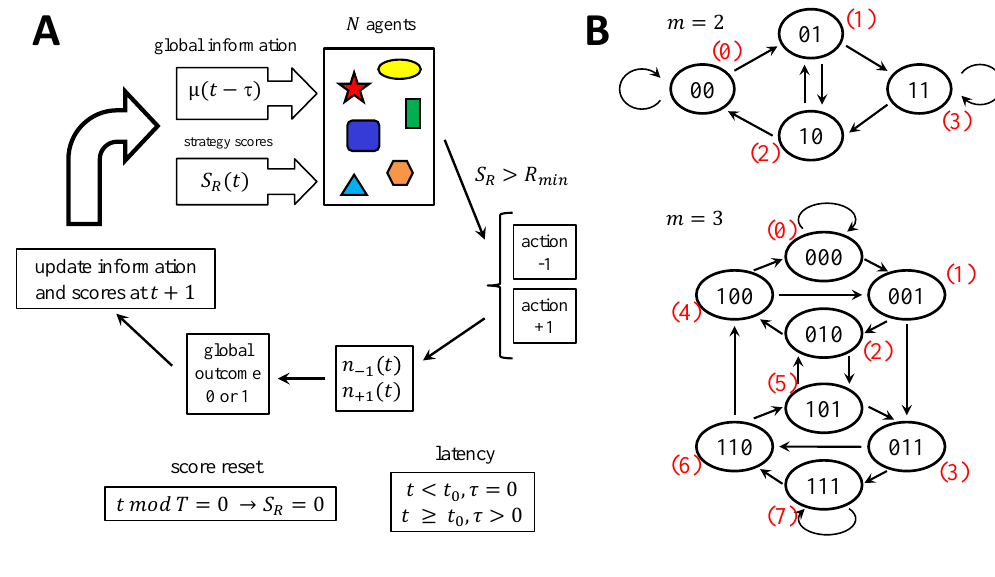
Figure 4. ( A ) The Delayed Grand Canonical Minority Game (DGCMG) that we study in this paper, is a modification of the Grand Canonical Minority Game which was introduced in Ref. [23]. Specifically it has an added temporal delay in the feedback of global information to the agents, as compared